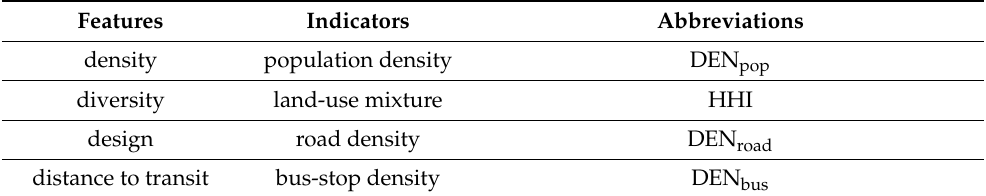
Table 3. The indicators of urban built environment based on “5Ds”